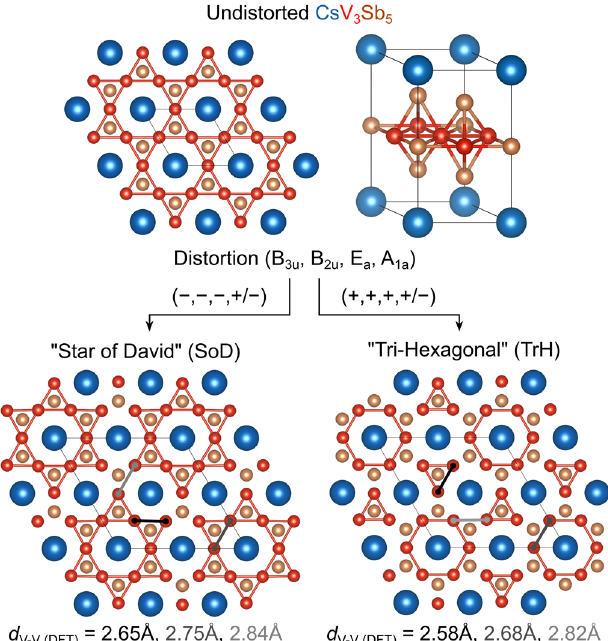
FIG. 1. CsV 3 Sb 5 is a layered, exfoliatable, kagome metal consisting of a structurally perfect lattice of vanadium at room temperature. Upon cooling below T (cid:2) ¼ 93 K, CsV 3 Sb 5 exhibits charge density wave order. A concurrent structural distortion emerges as well, which is suspected to be related to the kagome “ breathing mode. ” Upon distortion and relaxation in both the positive and negative displacements, the breathing mode gives rise to the Star of David (SoD) and trihexagonal (TrH) candidate